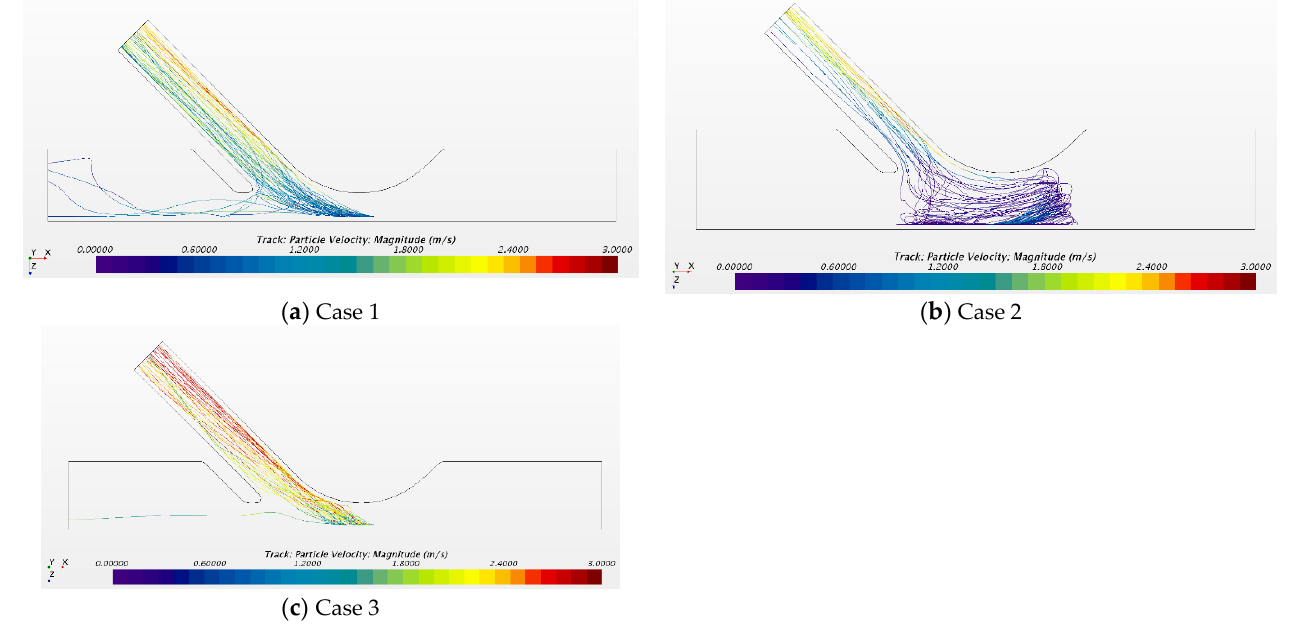
Figure 18. Track file of particles of the three